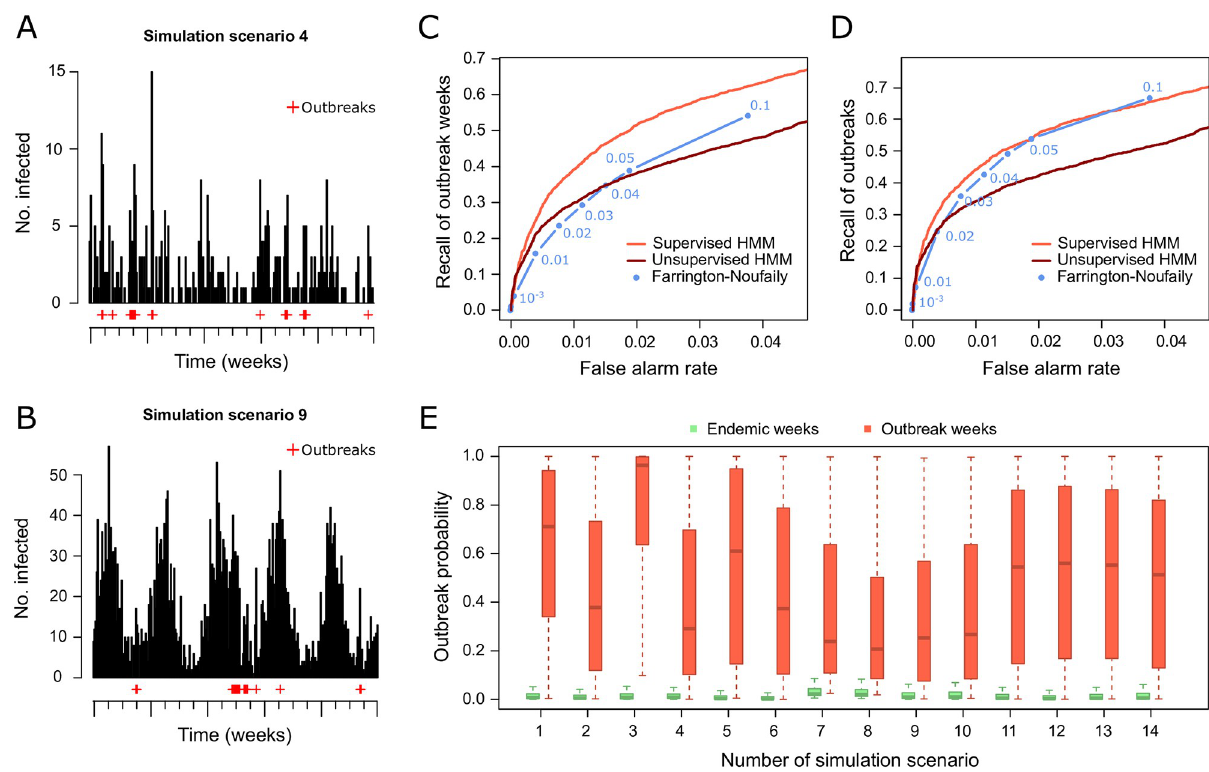
Fig 2. Benchmark of the negative Binomial hidden Markov model (HMM) and the Farrington-Noufaily algorithm on simulated data set. (A) Example simulated time series for scenario 4. (B) Example simulated time seires for scenario 9. (C) ROC curve showing the false alarm rate and recall of oubtreak weeks for all 14 simulation scenarios. (D) ROC curve showing the false alarm rate and recall of oubtreaks for all 14 simulation scenarios. (E) Boxplots of posterior probabilities of known endemic (green) and outbreak (red) weeks for all 14 simulation scenarios.